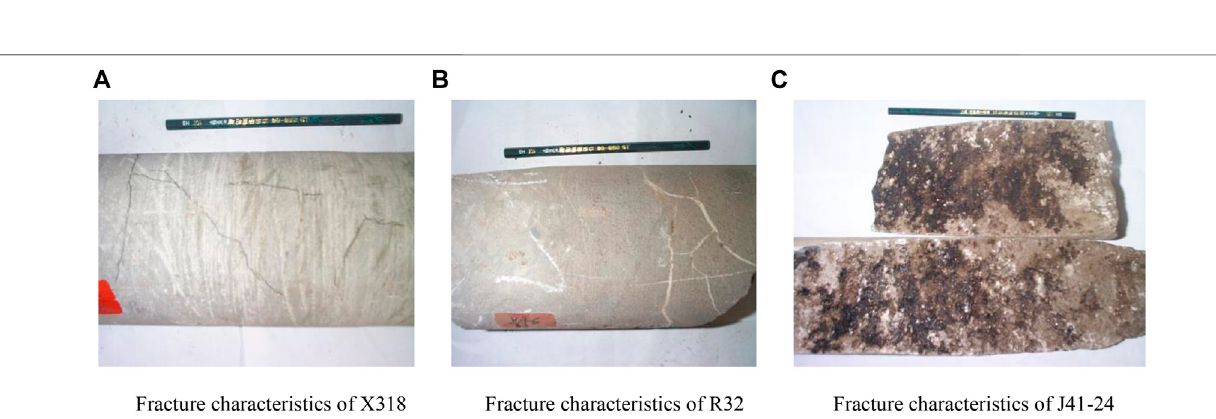
Frontiers in Earth Science |